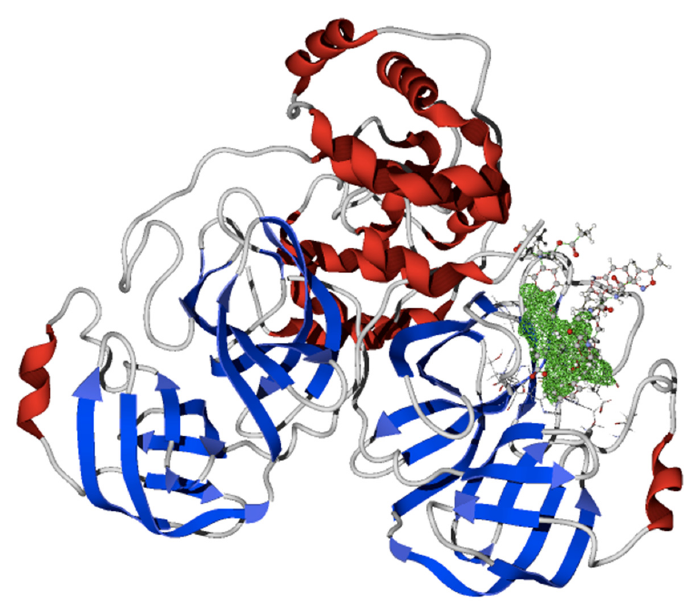
Figure 2. Molecular docking between the SARS-CoV-2-M pro and the studied ligands.